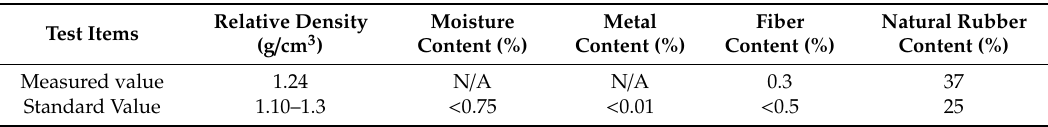
Figure 1. Close-up photos and SEM photo of regular rubber particle. Table 2. Physical properties of crumb